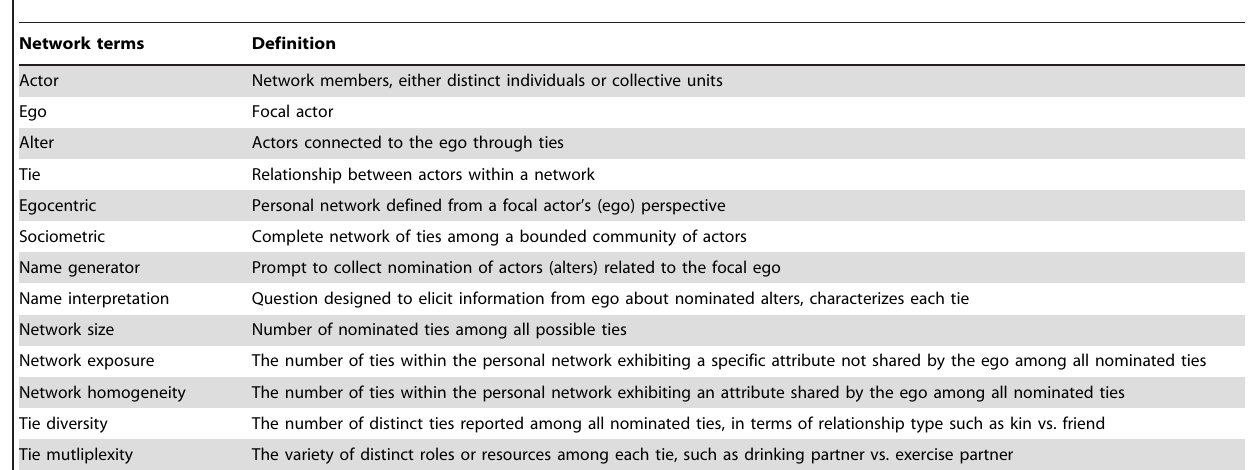
Table 1. Social network